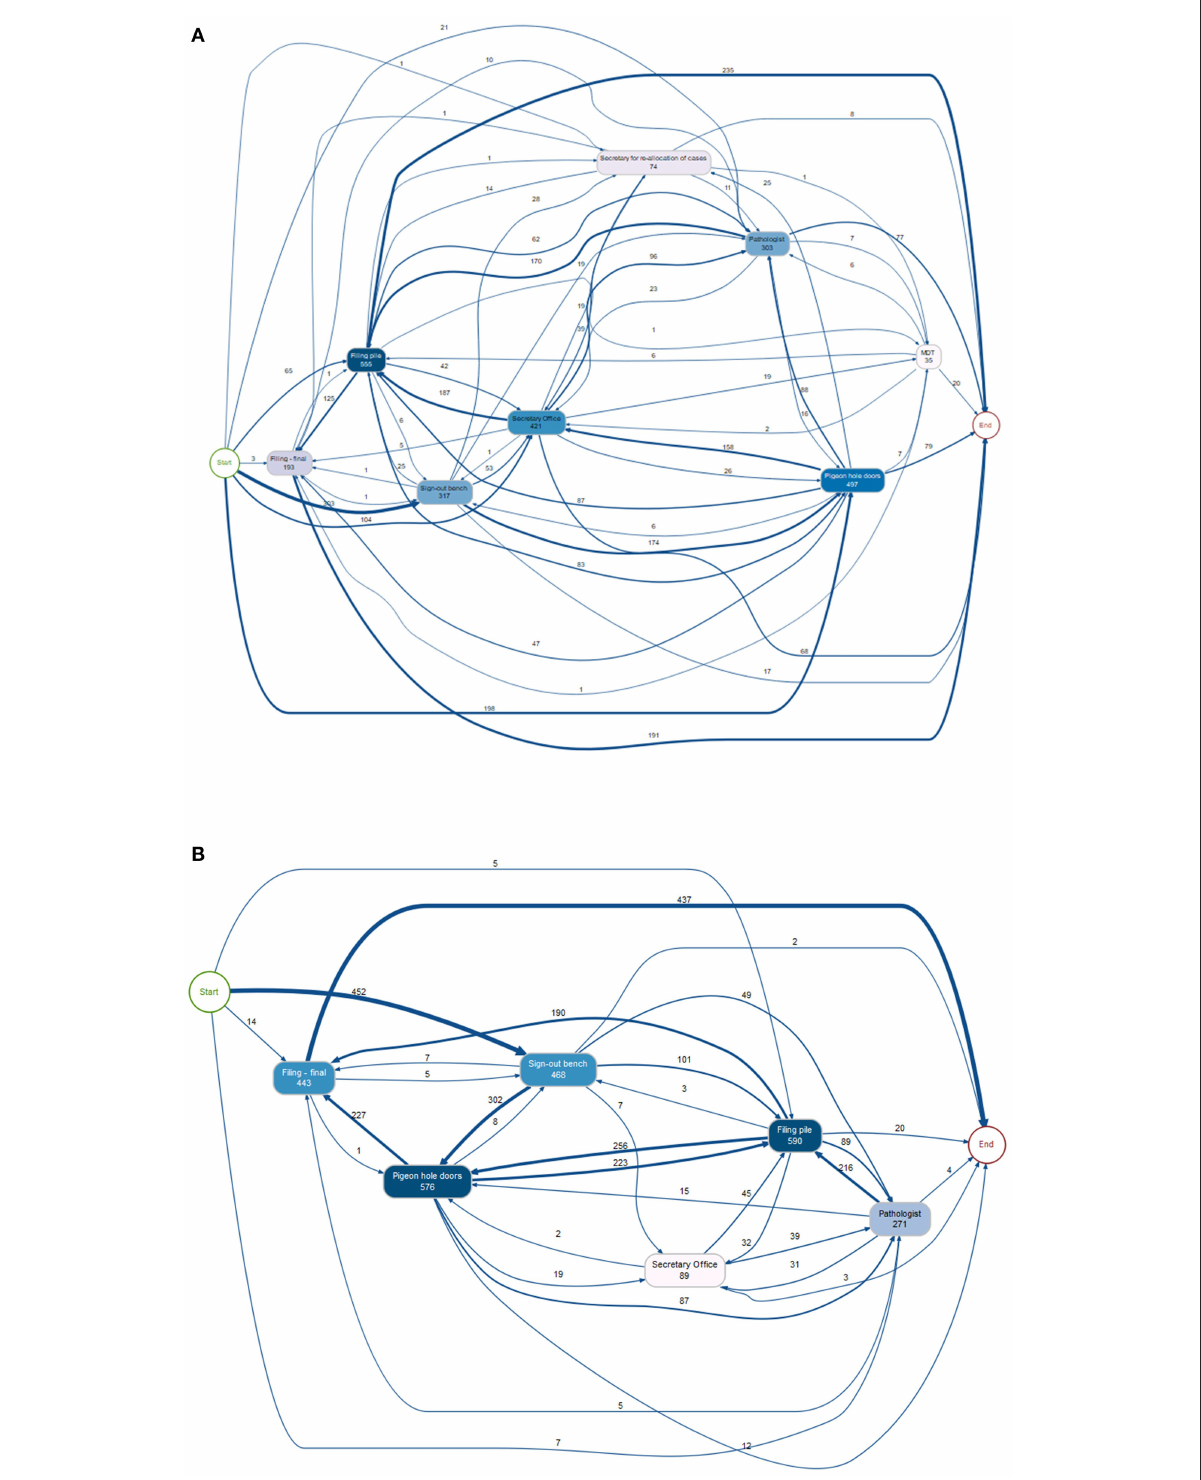
FIGURE4 Diagrams showing the tracking of cases during the study period, with the number of cases following each pathway and being registered at each workflow point as shown, some being registered more than once at each point. (A) Study period 1 (695 cases). The movement of cases from the PH to the secretary for redistribution amongst a specialty team of pathologists, and then back to the PH for collection by a pathologist is shown (74 reads), as well as the movement of cases to the MDT pile for collation for the weekly meeting (35 reads), with 20 being returned to filing during the study period. (B) Study period 2 (478 cases). PH , pigeon holes; MDT, multidisciplinary